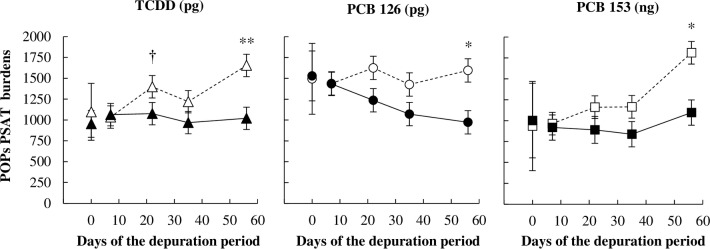
Time pattern kinetics of TCDD, PCB 126 and 153 pericaudal subcutaneous adipose tissue (PSAT) burdens in ewes receiving a control well-fed and non-supplemented treatment (CTL: Δ, ○, □) or an underfed and mineral oil supplemented treatment (UFMO: ▲, ●, ■).Each point represents the least-squares mean, and error bars indicate SEM except at day 0, for which they represent the mean and SE. The * and ** symbols indicate a significant (P ≤ 0.05 and P ≤ 0.01, respectively) and † a tendency toward significance (P ≤ 0.10) for treatment effect on the considered day.